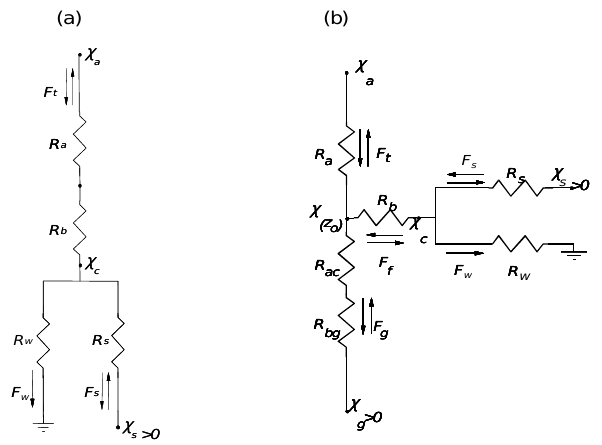
Figure 1 Fig. 1. Big leaf (a) and two layer (b) resistance scheme for bi- directional NH 3 exchange between the vegetation and the atmo- sphere from Sutton et al. (1995b). F t , F s , F w and F g are the total, stomatal, cuticular and ground layer fluxes of NH 3 respectively; R a , R b , R w , R s , R ac and R bg are the aerodynamic, leaf boundary layer, cuticular, stomatal, in canopy aerodynamic and ground boundary layer resistances to exchange; χ a is the atmospheric NH 3 concen- tration; χ c , χ s and χ g are the canopy, stomatal and ground layer NH 3 compensation points